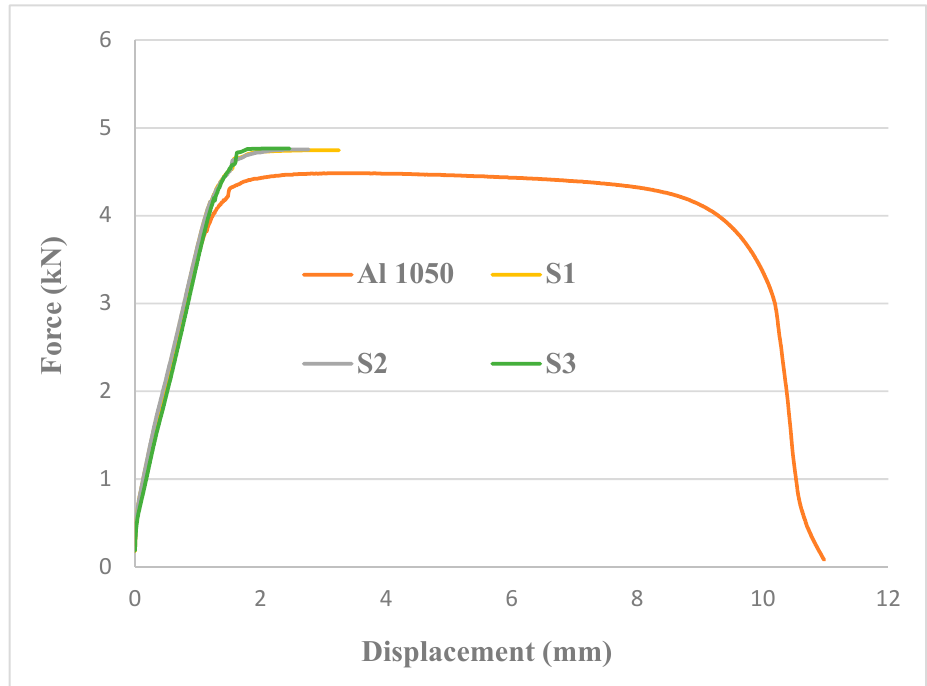
Figure 13. Comparative tensile test between Al 1050 and composite metal foil manufacturing (CMFM) specimens. J. Compos. Sci. 2018 , 2 , x